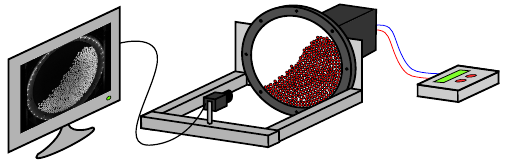
Figure 1. Schematic representation of the experimental setup consisting of a drum and grains in Plexiglas cut with a laser cut- ter. The drum is rotated by a stepper motor and rotation speed is set with a control unit. Images are taken with a monochromatic Thorlabs